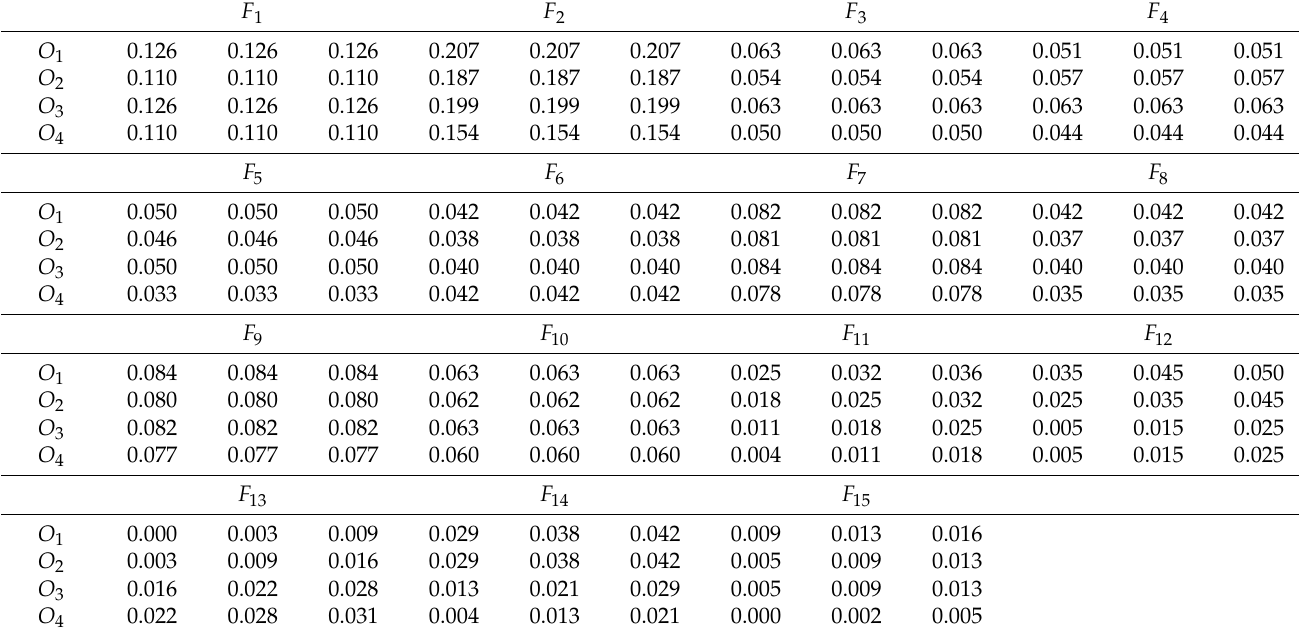
Table 16. Weighted normalization